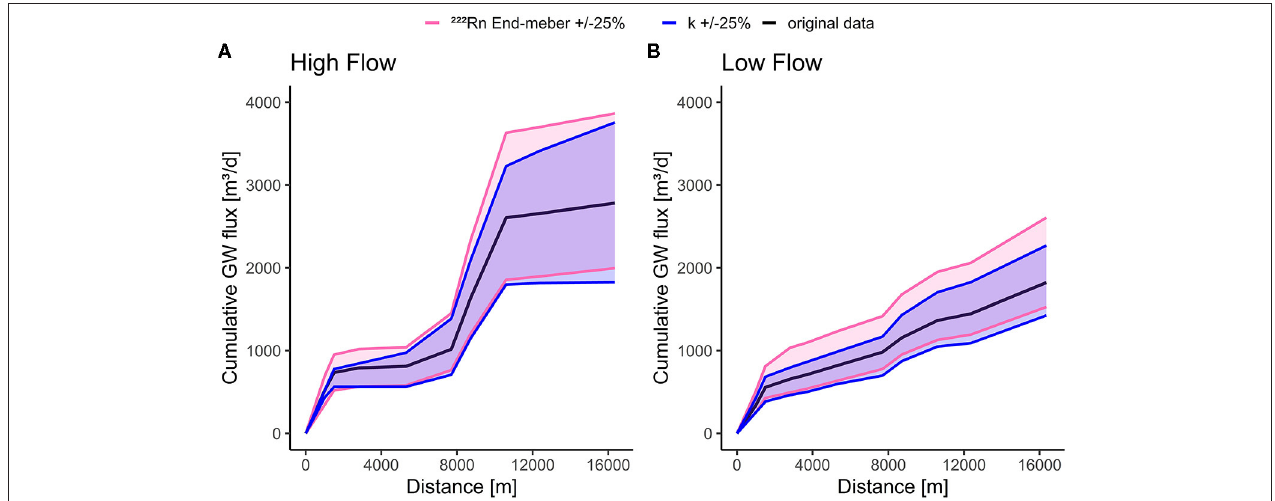
FIGURE 7 | Sensitivity of the mass-balance model to the groundwater end-member and degassing co-efficient k. The 222 Rn end-member activity and k were varied by ± 25% for cumulative groundwater flux for time periods with the highest discharge (March 19, 2019) (A) and lowest (July 13, 2020) (B)